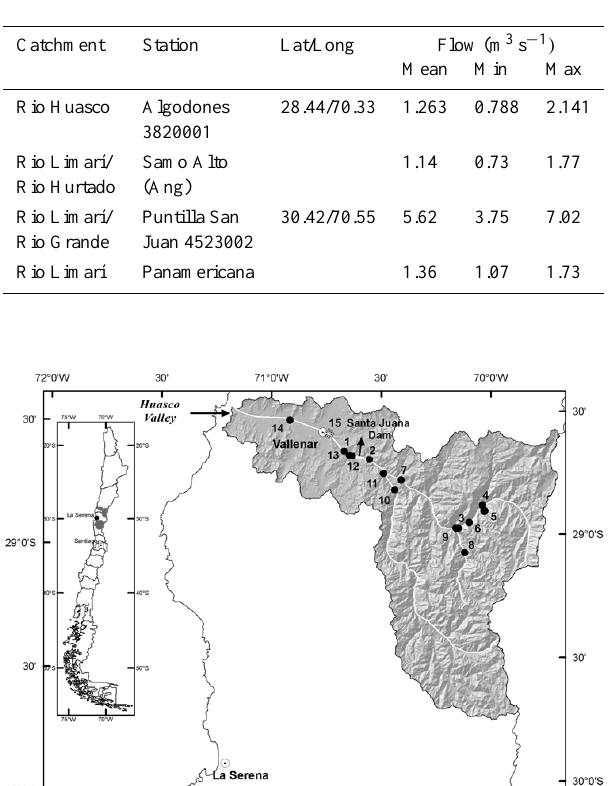
Table 1. Run-off data from the catchment areas investigated at DGA-Stations in November 2006 (DGA, 2007).